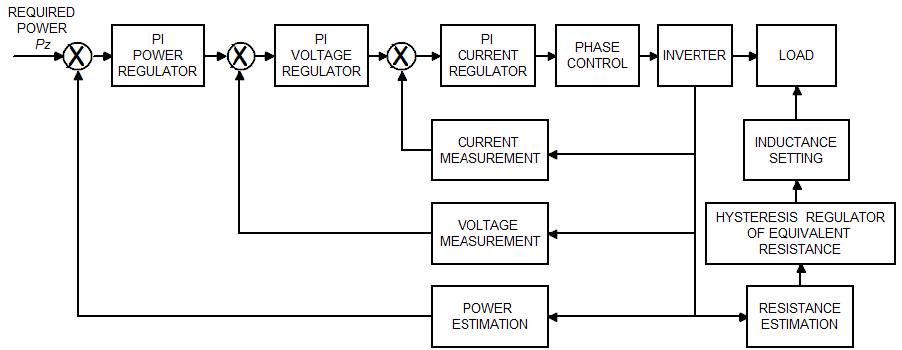
Figure 13. Block diagram of the cascade power regulator in the induction heating generator model.